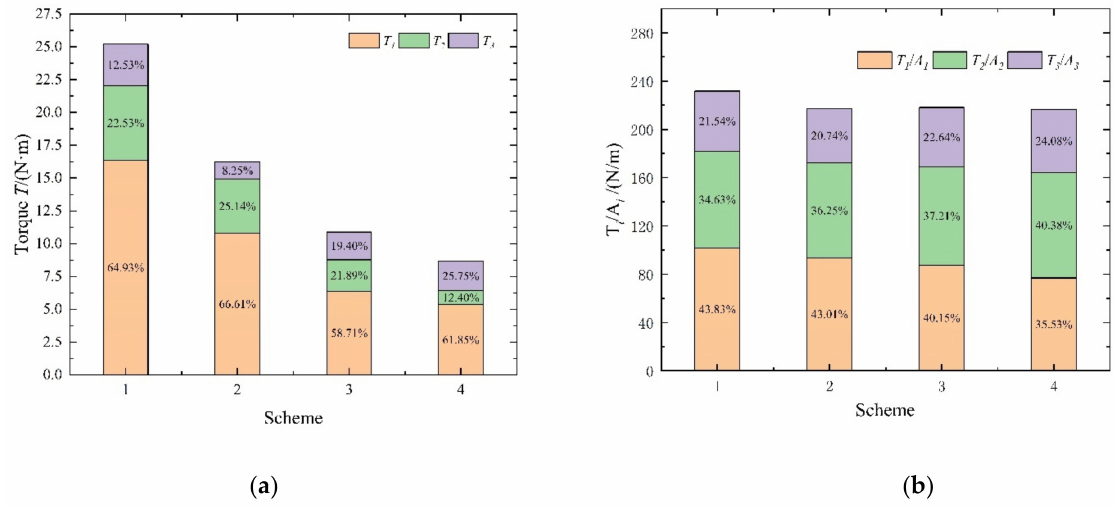
Figure 18. Torque diagram of different schemes. ( a ) The torque of each scheme, ( b ) The ratio of torque to